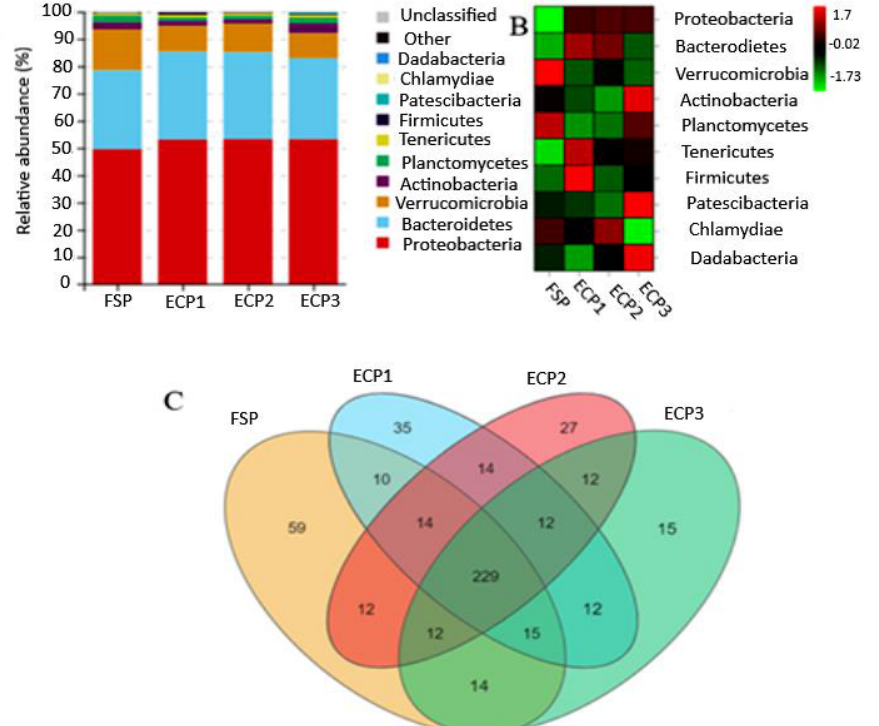
Figure 1. Effect of fish soluble pulp and enzymatic chicken pulp on the bacterial species composition of the intestinal microbiota community of L. vannamei . ( A ) Taxonomic distribution; ( B ) Heat map; ( C ) Venn diagram.